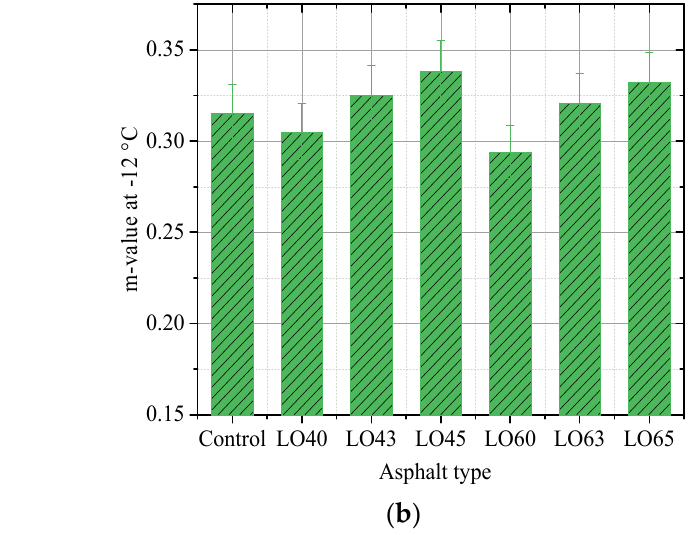
Figure 7. The BBR results at − 12 °C. ( a ) Stiffness; ( b ) m-value.